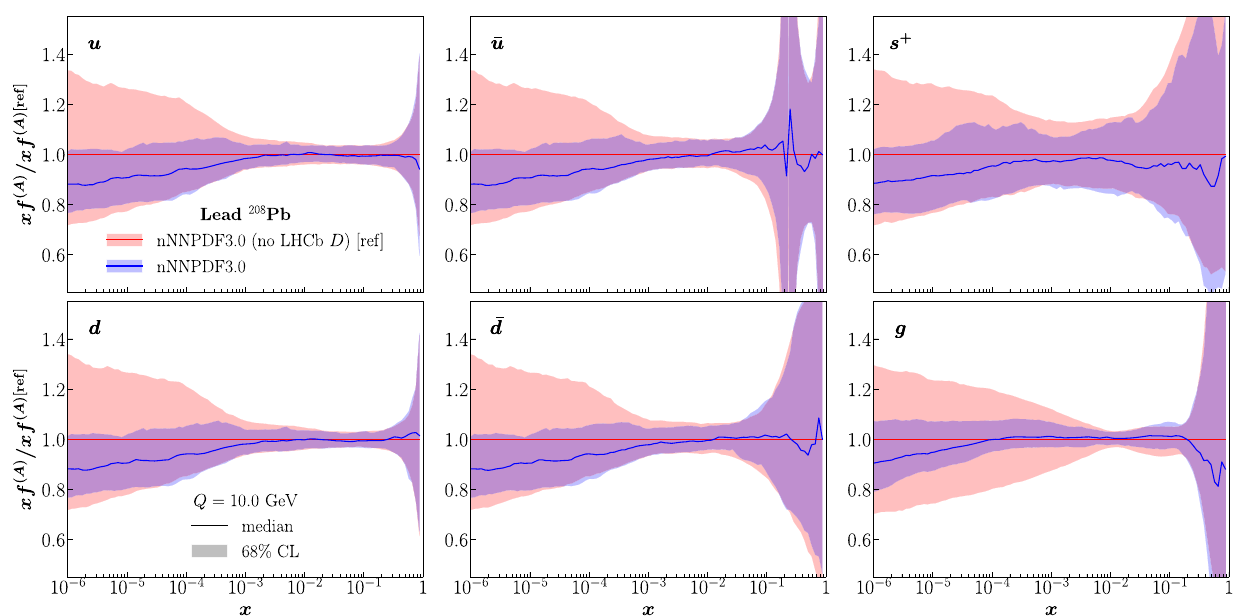
Fig. 9 Comparison of the nPDFs of lead nuclei at Q = 10 GeV between nNNPDF3.0 (no LHCb D ) and nNNPDF3.0, normalised to the central value of the